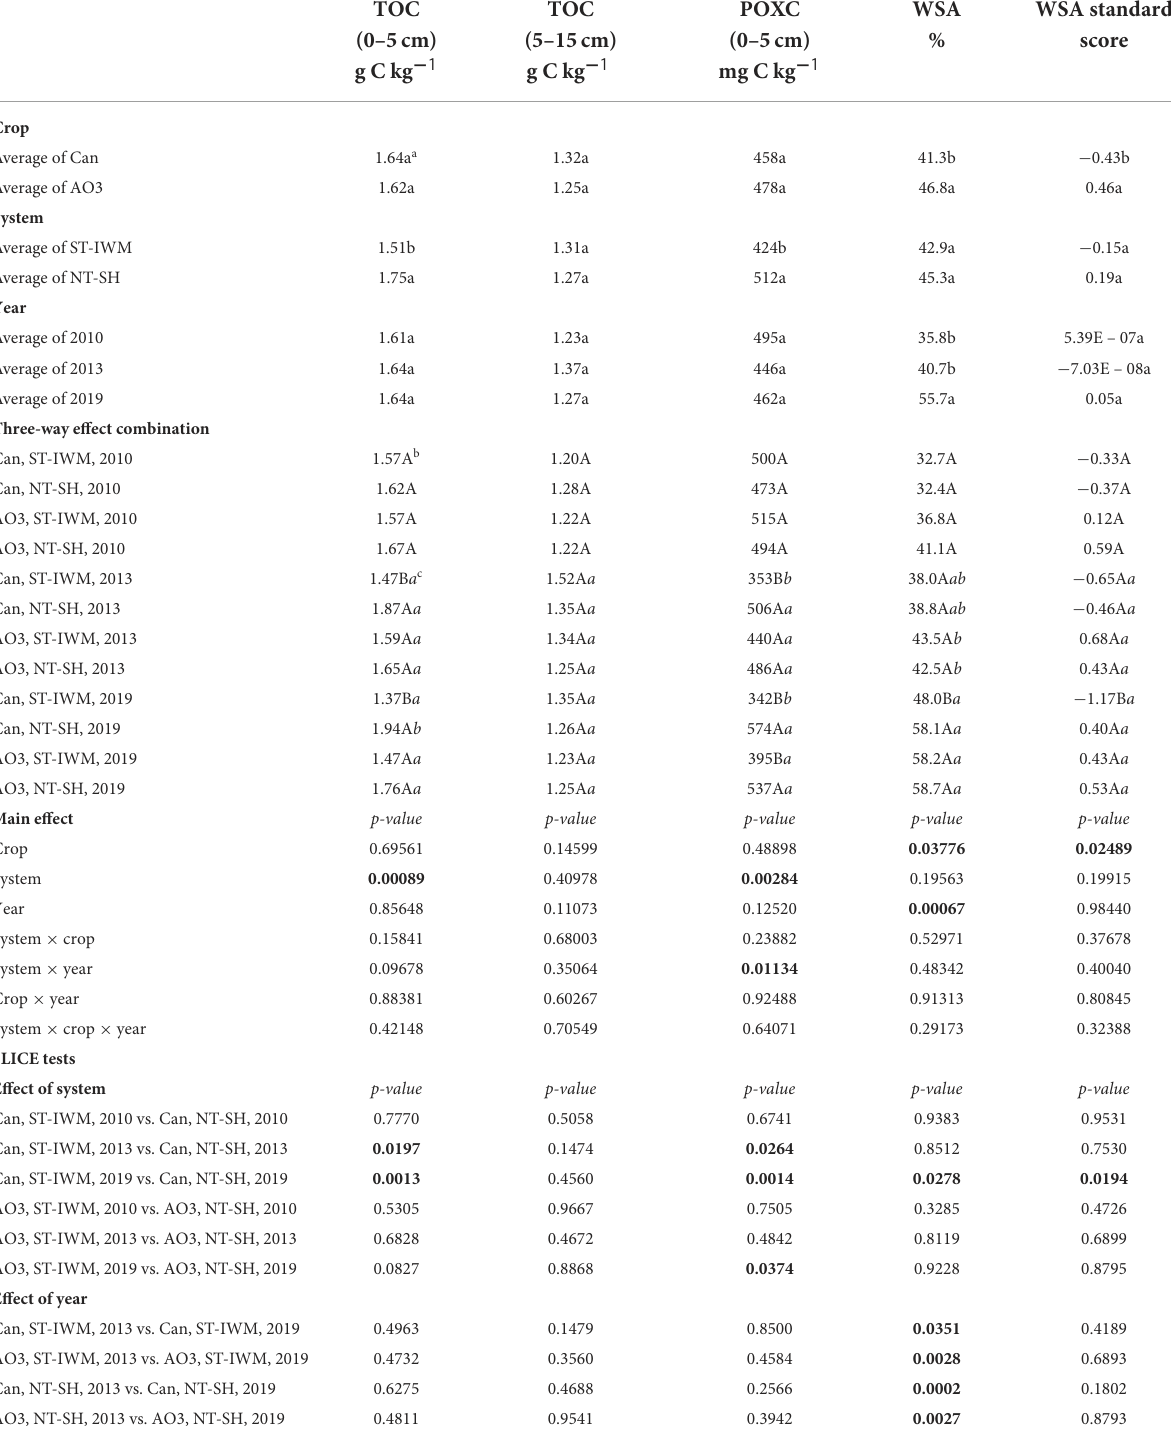
TABLE 2 Total organic carbon (g C kg soil − 1 ) at 0–5cm and 5–15 cm, labile carbon by POXC (mg C kg soil − 1 ) at 0–5cm, water stable aggregates at 0–15cm and water stable aggregate standard scores, calculated using the means and standard deviation of within-year score compared in